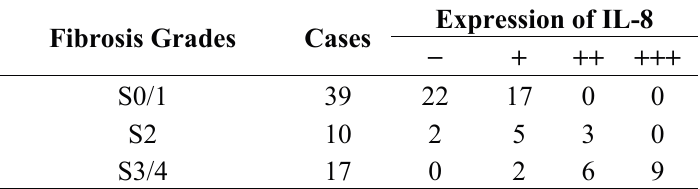
Table 3. The relationship between the expression of IL-8 and the degree of liver fibrosis, r = 0.698, p <